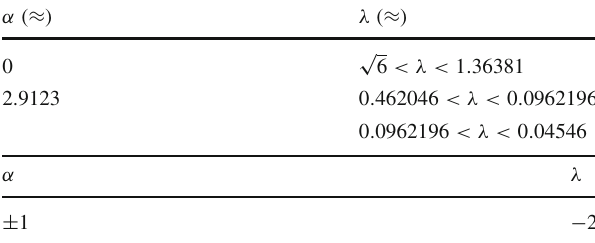
Table 4 D < 0: ranges of α and λ for complex conjugate